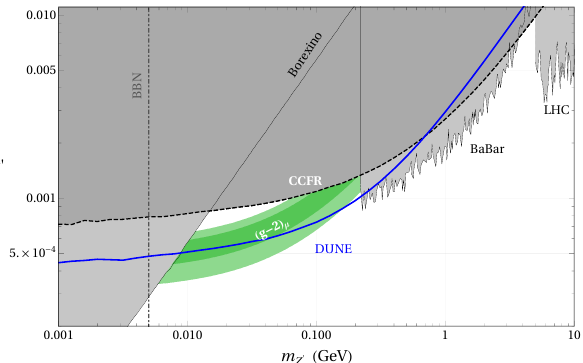
L τ parameter space. Figure 157. Existing constraints and projected DUNE sensitivity in the L µ − Shown in green is the region where the ( g 2 ) µ anomaly can be explained at the 2 σ level. The − parameter regions already excluded by existing constraints are shaded in gray and correspond to a µ + µ − Z (cid:48) µ + µ − µ + µ − [249] (“LHC”), a BaBar search for e + e − µ + µ − Z (cid:48) CMS search for pp → → → → µ + µ − µ + µ − [250] (“BaBar”), a previous measurement of the trident cross Section [247,251] (“CCFR”), a measurement of the scattering rate of solar neutrinos on electrons [252–254] (“Borexino”), and bounds from Big Bang Nucleosynthesis [255,256] (“BBN”). The DUNE sensitivity shown by the solid blue line assumes 6.5 years of data running in neutrino mode, leading to a measurement of the trident cross section with 40%